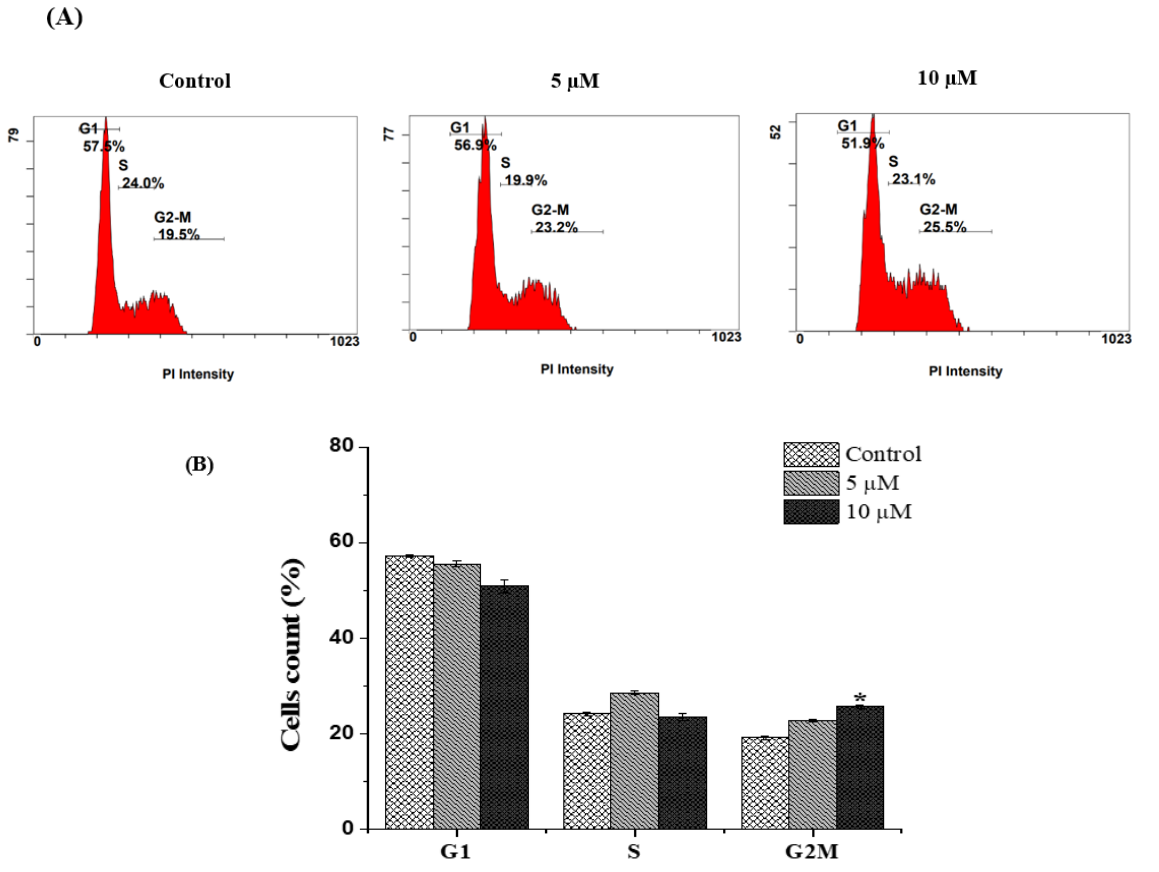
Figure 2. Effect of chlorojanerin on cell cycle phases of human lung cancer cells. A549 cells were treated with chlorojanerin (5 and 10 µ M) for 24 h. ( A ) Representative flow cytometric histogram of cell cycle progression in the A549 after particular treatments. ( B ) Bar graph displaying the percentage of total population of cells. Results are presented as the mean ± S.D. from three experiments. * p < 0.05 vs. untreated control.